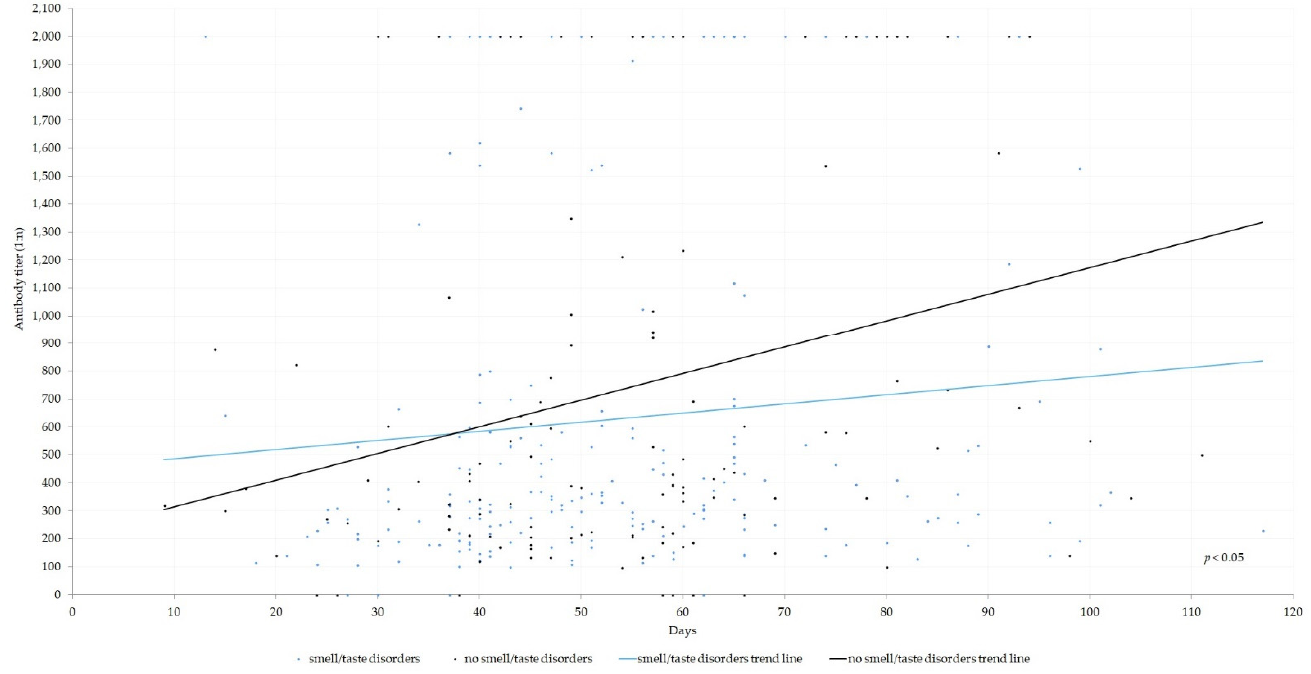
Figure 2. Anti-SARS-CoV-2 antibodies among patients depend on smell/taste disturbances. The chi-square test was used to derive the p -values.